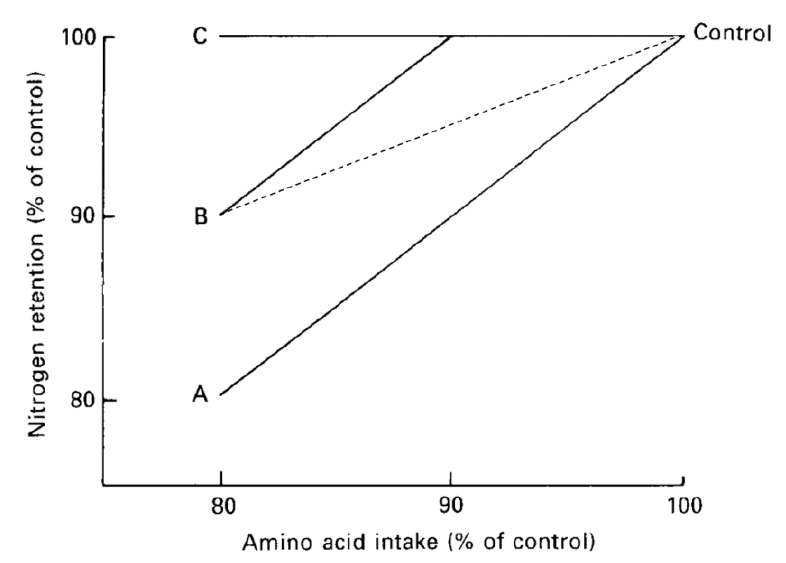
Figure 1. In this model, amino acid intake (AAI) should be presented as the percentage or ratio to control treatment for better distinguishing differences of NR among three AA deleting treatments. To keep the linear relationship between the NR and the first limiting amino acid, the NR should also be converted to the percentage or ratio of the control treatment. The model assumes that deleting the first limiting amino acid (as A) reduces NR to the greatest extent (largest slope); deleting C does not reduce the NR at all (slope = 0), as it remains in excess (over 20%) relative to the first limiting amino acid. Deleting B results in a reduction in the NR intermediate between A and C (0 < Slope B (dashed) < Slope A), and part of B is in excess relative to the first limiting amino acid. In other words, A is the first limiting amino acid while B is second limiting amino acid. According to the principle of the “wooden barrel”, all essential AAs can be controlled by the same limitation by adjusting the amount of AAs in the diet. In this model, B is 10% more than A, which means that we should reduce 10% of B from the control treatment to achieve the minimum addition and ensure it is co-limiting with A [9]. Then, we can calculate the ratio of A and B.